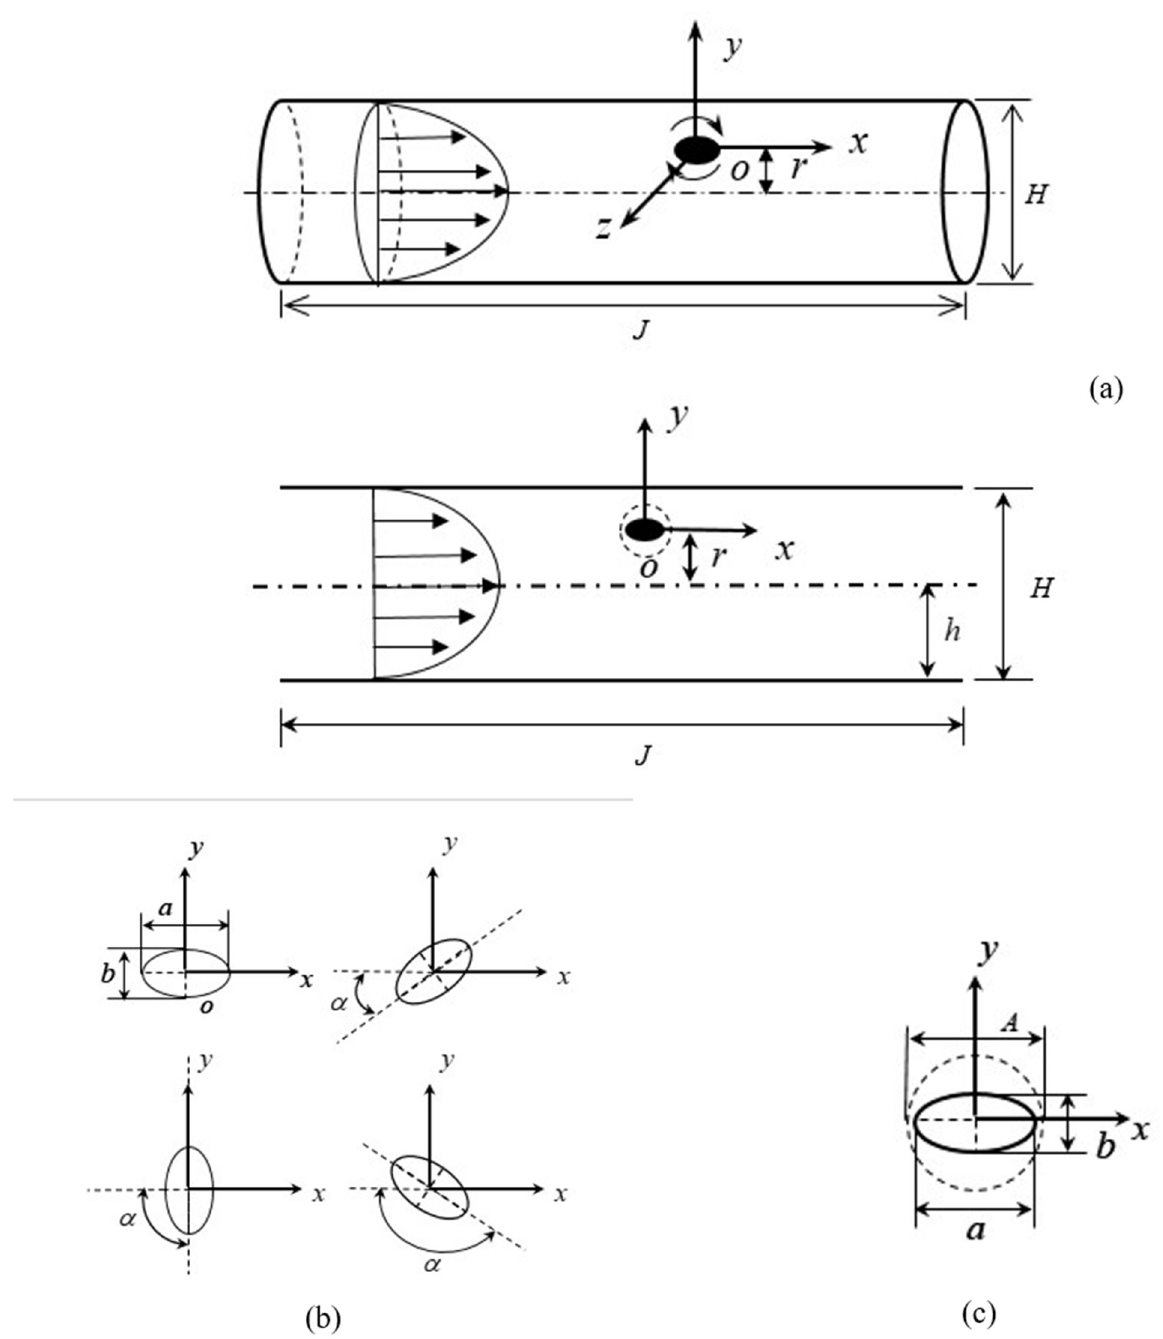
Fig 1. The schematics for the numerical model. (a) Schematic diagram of pipeline flow simplification, (b) rotation diagram of elliptical particles and (c) adjacent to the rotating domain particles. of the pipe wall motion, and ω will be attributed in a specific rotation area. For the transla- p tional motion, the trial and error method first assumes a velocity U for trial calculation, p 0 determines the resultant force F of particles along the flow direction ( x direction), and ascer- x 0 tains whether the magnitude order of force is zero within a particular accuracy. If it is not zero,